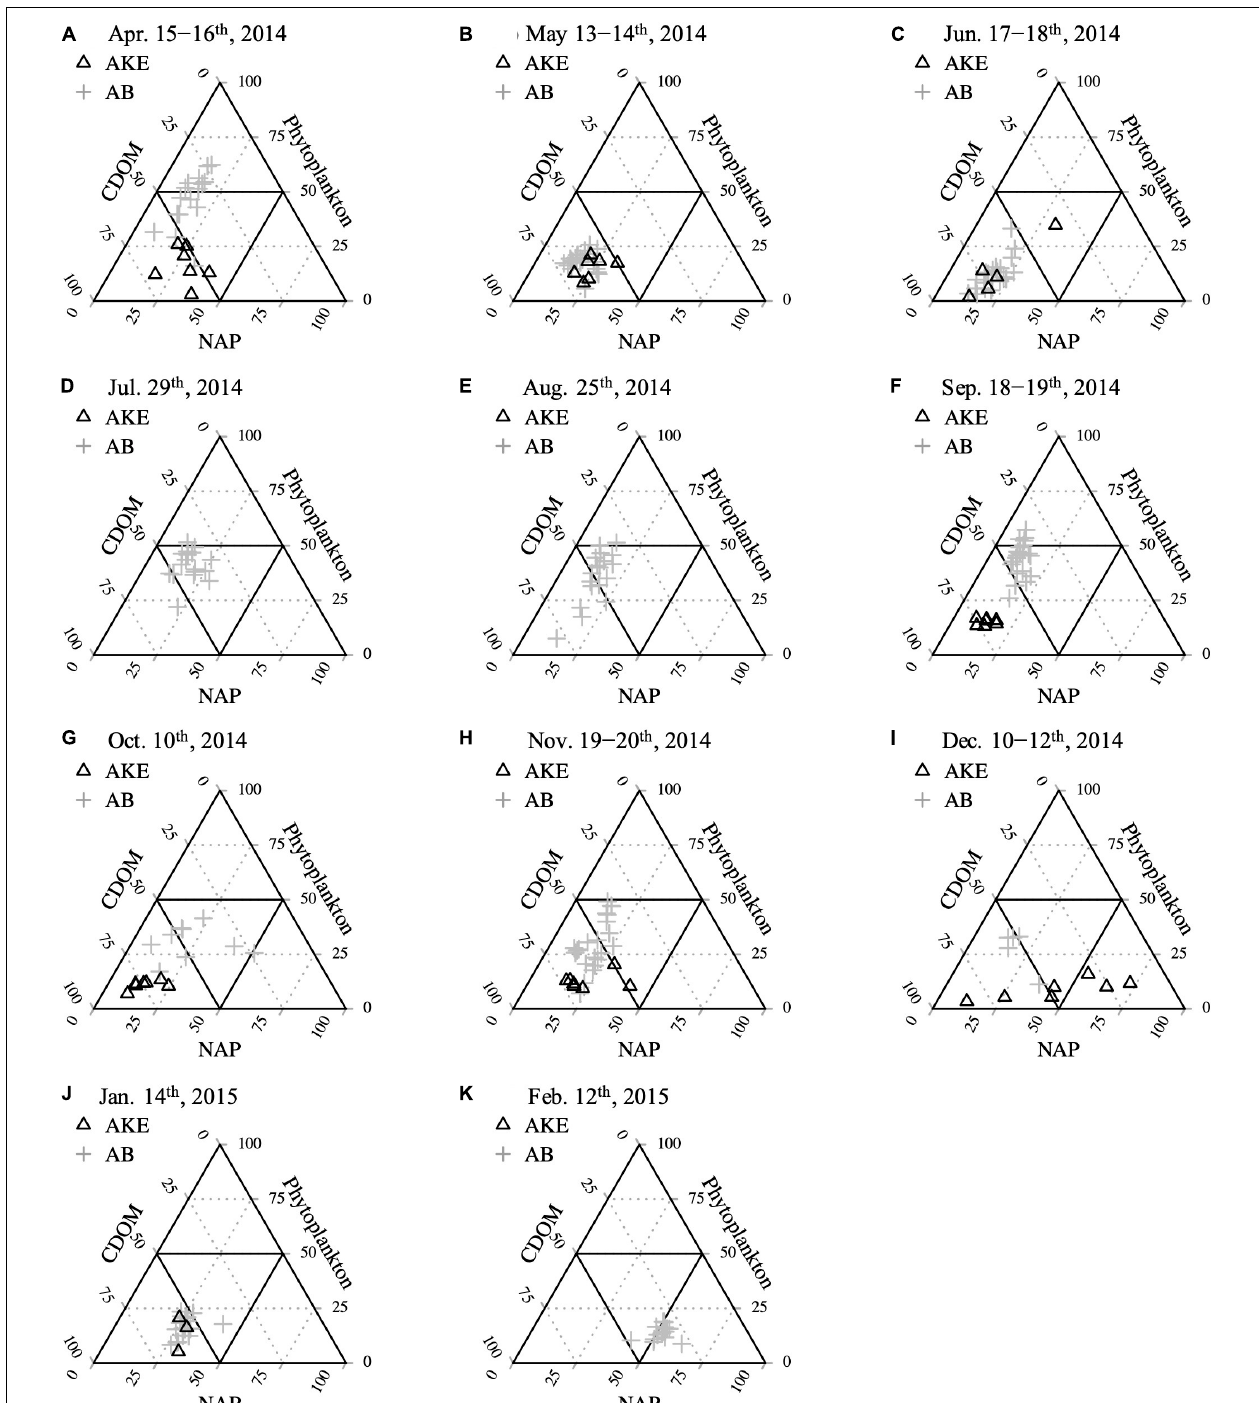
FIGURE 7 | Relative contributions of CDOM, NAP, and the phytoplankton absorption component to total non-water absorption at 443 nm (A–K) from April 2014 to February 2015.